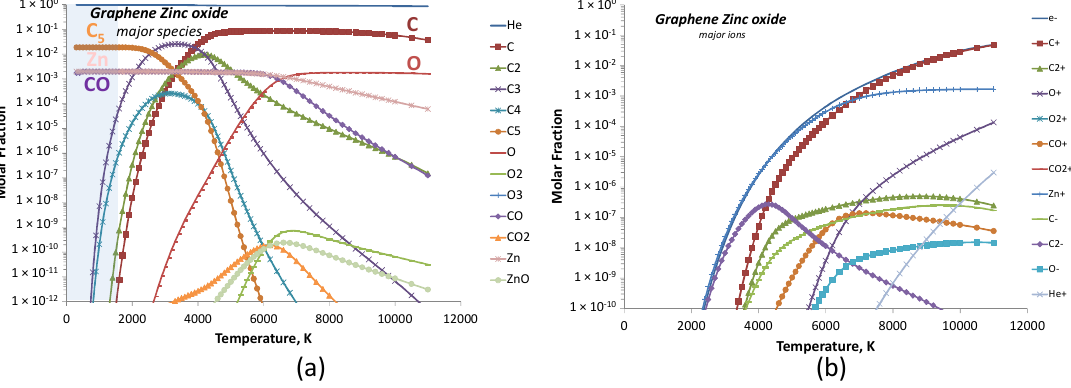
Figure 15. Calculated equilibrium species for GrCu conditions at a total pressure of 530 mbar: ( a ) major species with the cold cathode region schematized in the blue area and ( b ) major ions.